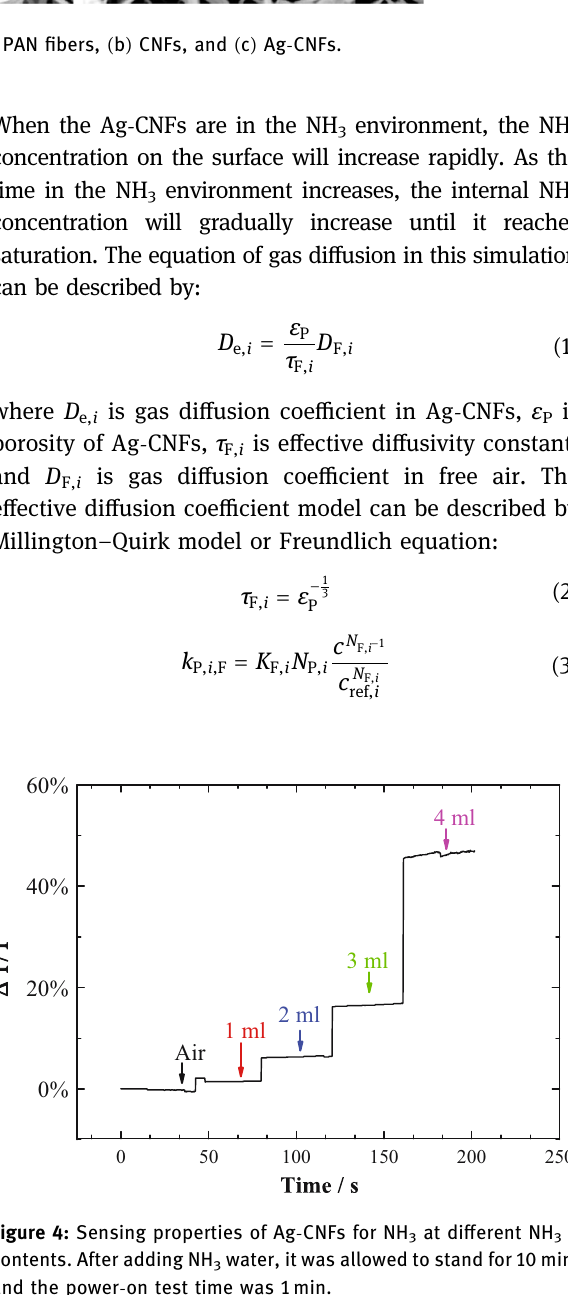
Figure 3: Schematic diagram of the device for Ag - CNF testing NH 3 concentration, the voltage applied during the test is 0.2 V.